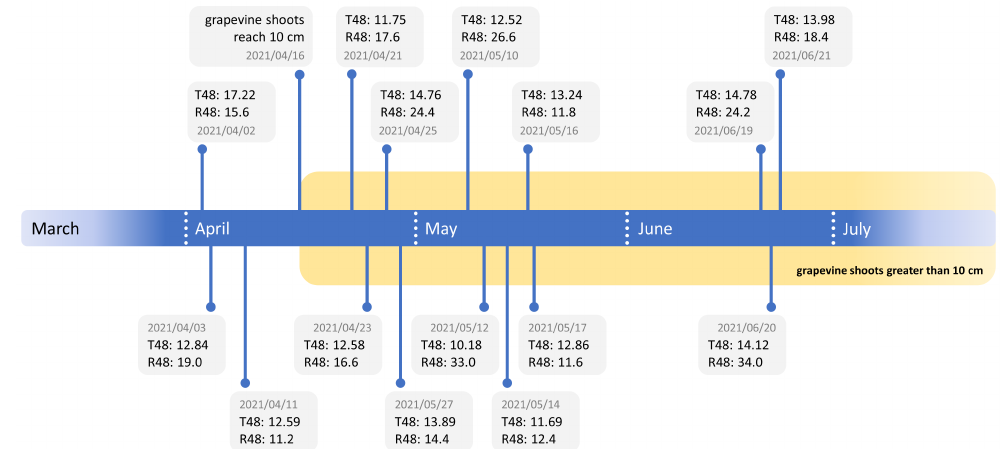
Figure 10. Timeline of generated events within the downy mildew prediction process. T48 represents the last 48 h average temperature and R48 the last 48 h total rainfall.